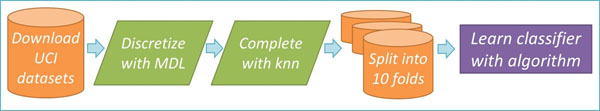
The procedure of data processing and classification.